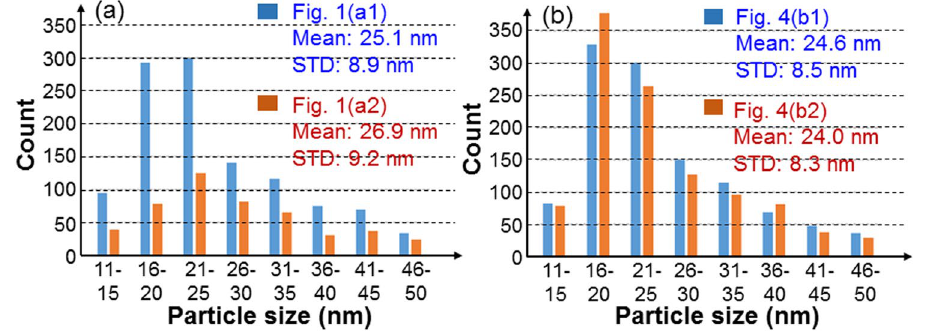
Figure 2. ( a ) Histograms of NP size distributions of the samples with the SEM images shown in Fig. 1(a1,a2). ( b ) Histograms of NP size distributions of the samples with the SEM images shown in Fig. 4(b1,b2). The mean and STD values of Ag NP size are also shown.